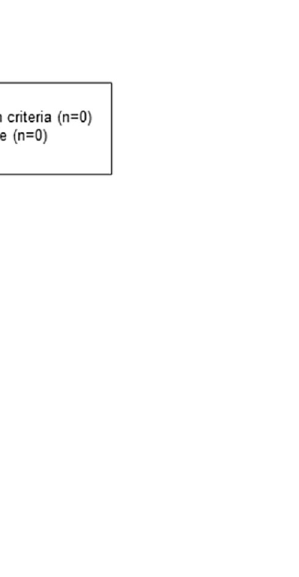
Fig 1. Consort flow diagram for clinical trial (EudraCT number